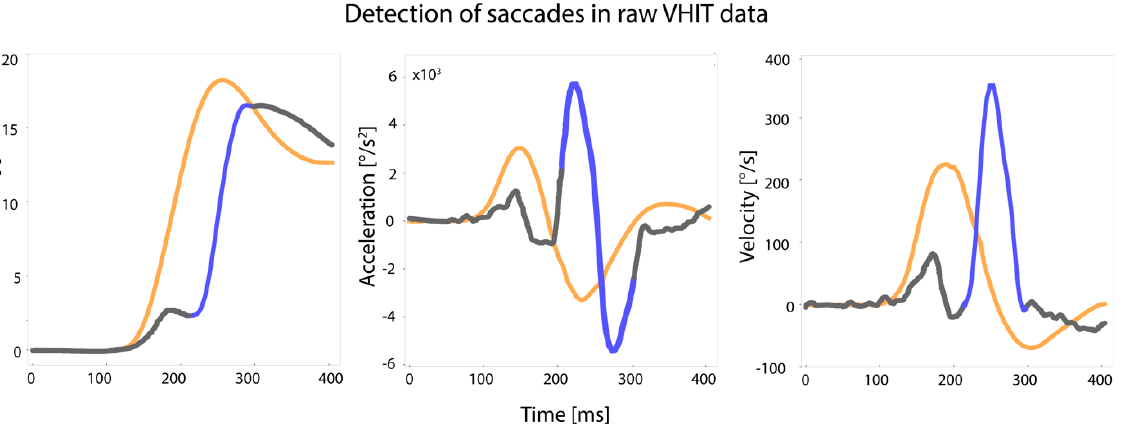
Figure 1. Detection of saccades in VHIT traces based on position, acceleration, and velocity of eye movement. The orange line illustrates the head impulse, the grey line represents the eye movement, and the blue line represents the saccade as included in the analysis. Raw data were exported from the Otometrics system (head and eye velocity traces). Position and acceleration data were calculated from these data. All traces were checked on artefacts and excluded if necessary. Saccades were extracted from these artefact-free traces using a custom-made algorithm. All saccades were verified by visual inspection. Definitions of artefacts and saccades are described in Section 2.3.